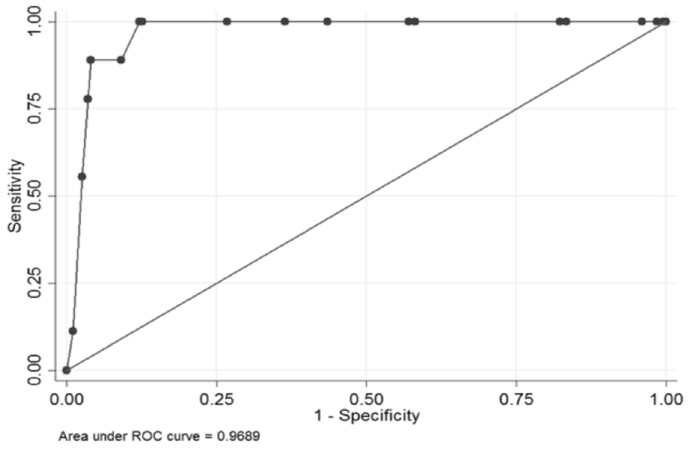
Figure 4. Area under the receiver operating characteristic (ROC) curve (AUC) of 96.9% .